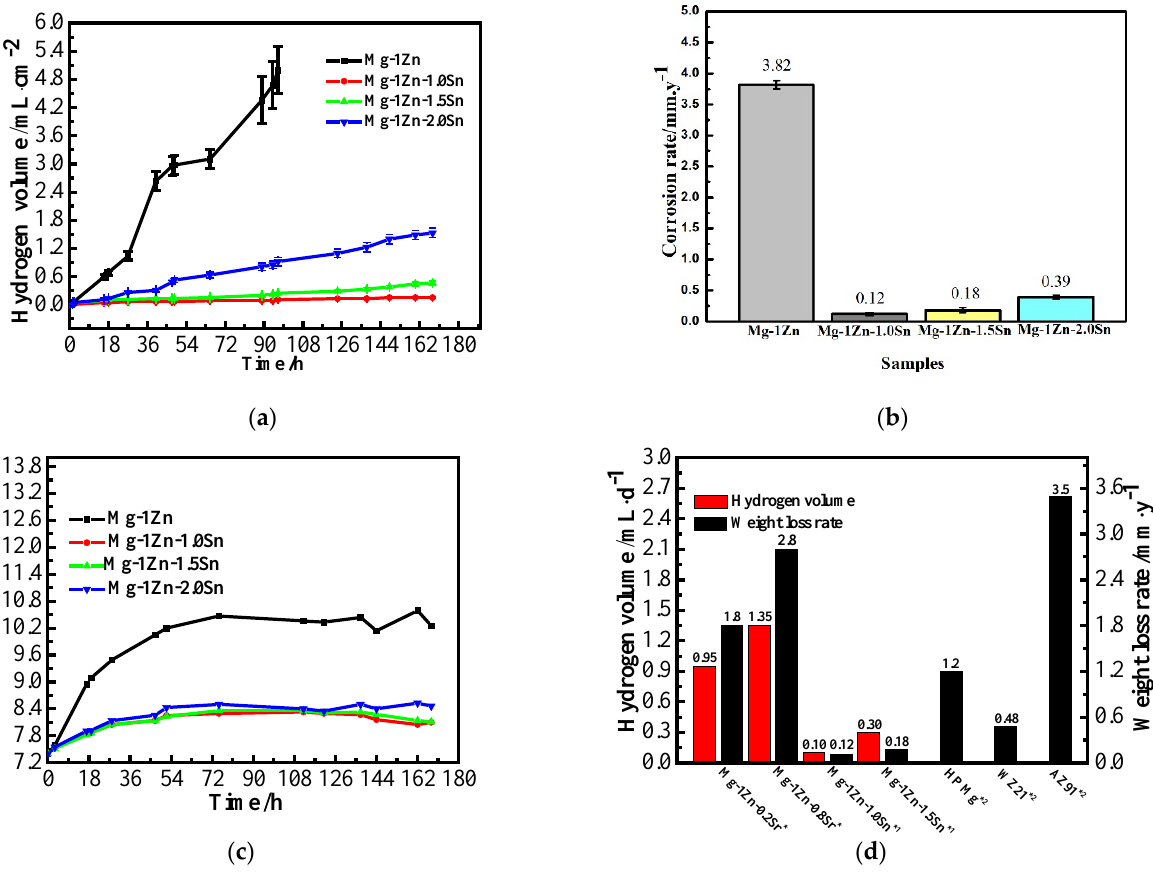
Figure 5. Immersion test results: hydrogen evolution ( a ), corrosion rate ( b ) by weight loss, and pH variation ( c ) of solution for Mg − 1Zn − xSn ternary alloys; degradation rate comparison ( d ) with some typical alloys.